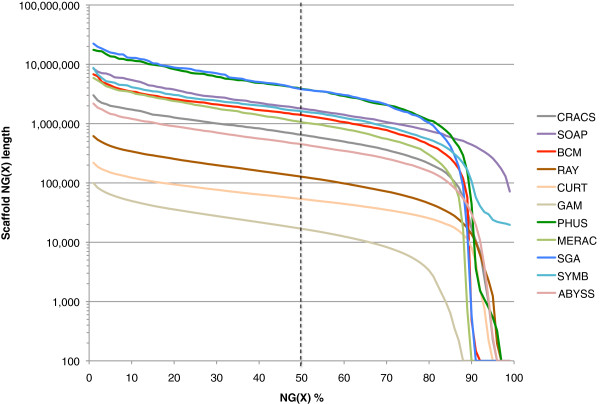
NG graph showing an overview of snake assembly scaffold lengths. The NG scaffold length (see text) is calculated at integer thresholds (1% to 100%) and the scaffold length (in bp) for that particular threshold is shown on the y-axis. The dotted vertical line indicates the NG50 scaffold length: if all scaffold lengths are summed from longest to the shortest, this is the length at which the sum length accounts for 50% of the estimated genome size. Y-axis is plotted on a log scale. Snake estimated genome size = ~1.0 Gbp.